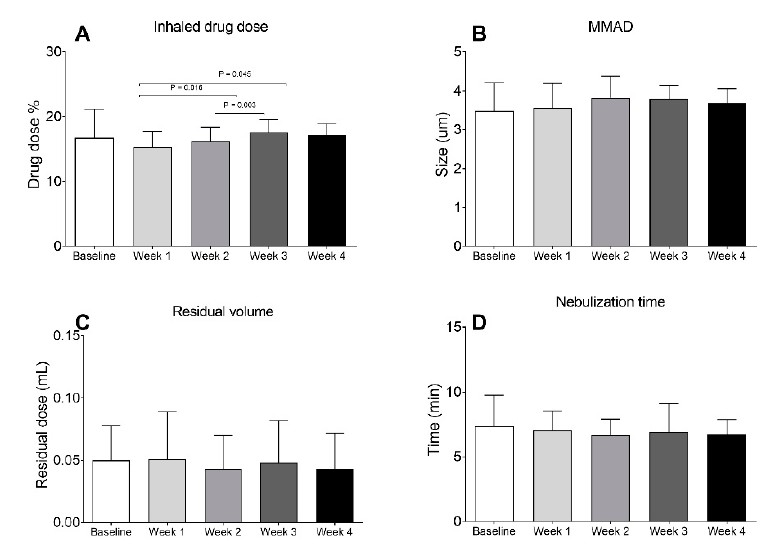
Figure 3. Comparison of nebulizer performance across four weeks of use: ( A ) Inhaled drug dose; ( B ) median mass aerodynamics (MMAD); ( C ) residual volume; and ( D ) nebulization time.